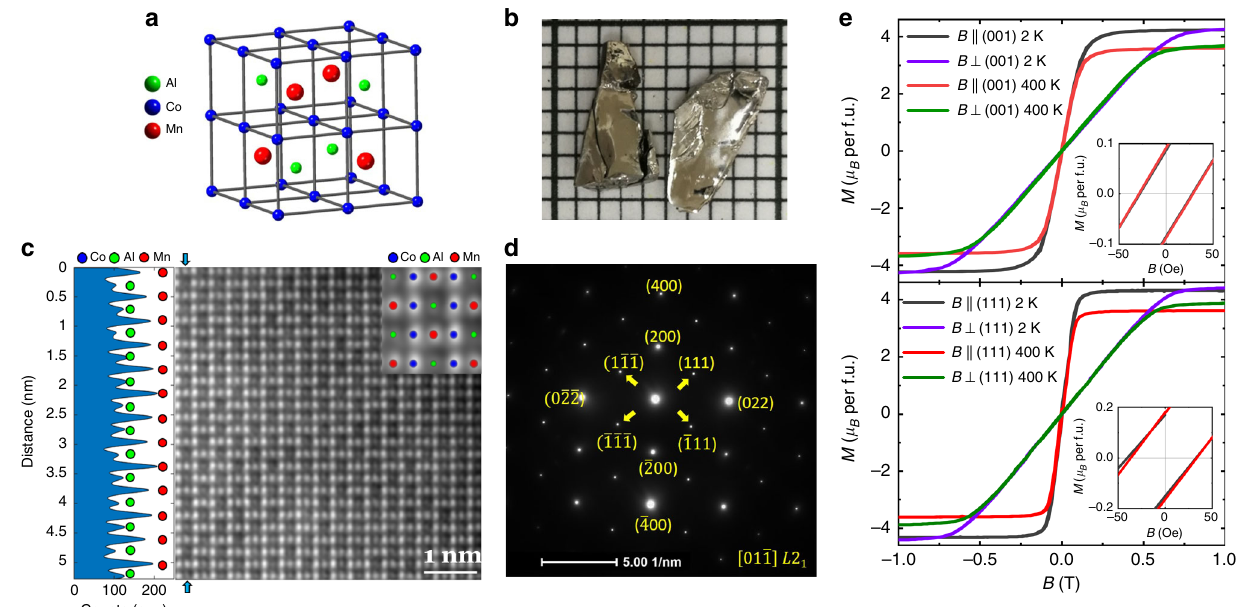
Fig. 1 Structure and magnetization of Co 2 MnAl single crystals. a Schematic crystal structure of L2 1 -type Co 2 MnAl; b the optical graph of Co 2 MnAl single crystals grown by the optical fl oating-zone method; c HAADF-STEM image of a selected area taken along the [110] zone axis. The left panel shows alternating intensity due to Z-contrast, revealing the ordering of Mn and Al; the right inset presents a magni fi ed image with the atoms overlaid on top. d The selected area diffraction pattern taken along the [110] zone axis. e The isothermal magnetization data at 2 and 400 K, measured with the magnetic fi eld applied parallel and perpendicular to the (001)/(111) plane, respectively. The insets show the enlargement of the magnetization around zero fi eld.